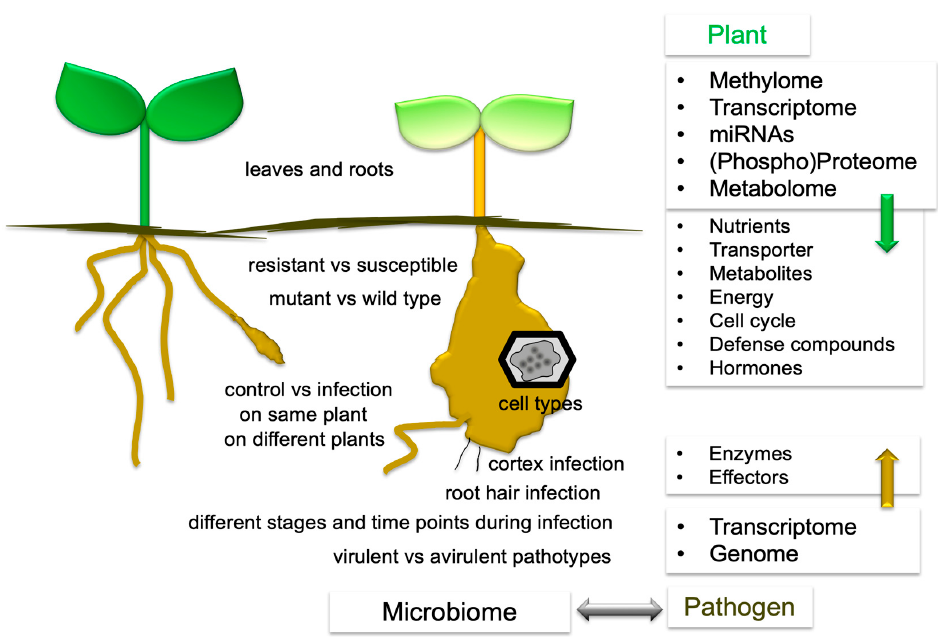
Figure 3. The experimental setups used for -omics studies with P. brassicae , as well as a summary of the results of the respective datasets. For either plant or pathogen, the -omics techniques are compiled on the right side. The results are partially integrated into a plant model together with the different genetic levels of regulation (see Figure 4).